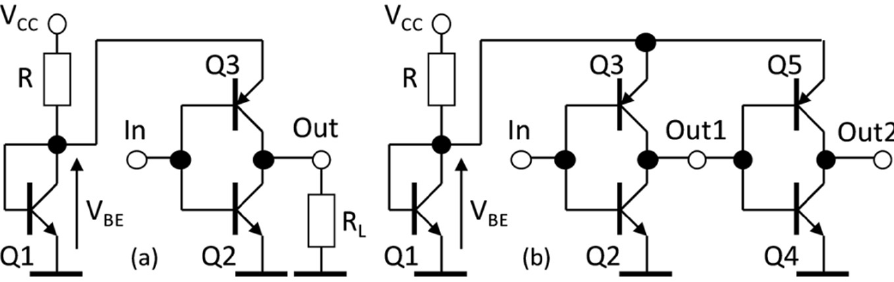
Figure 16. Inverters with resistive load ( a ) and nonlinear load—input of another inverter ( b ).